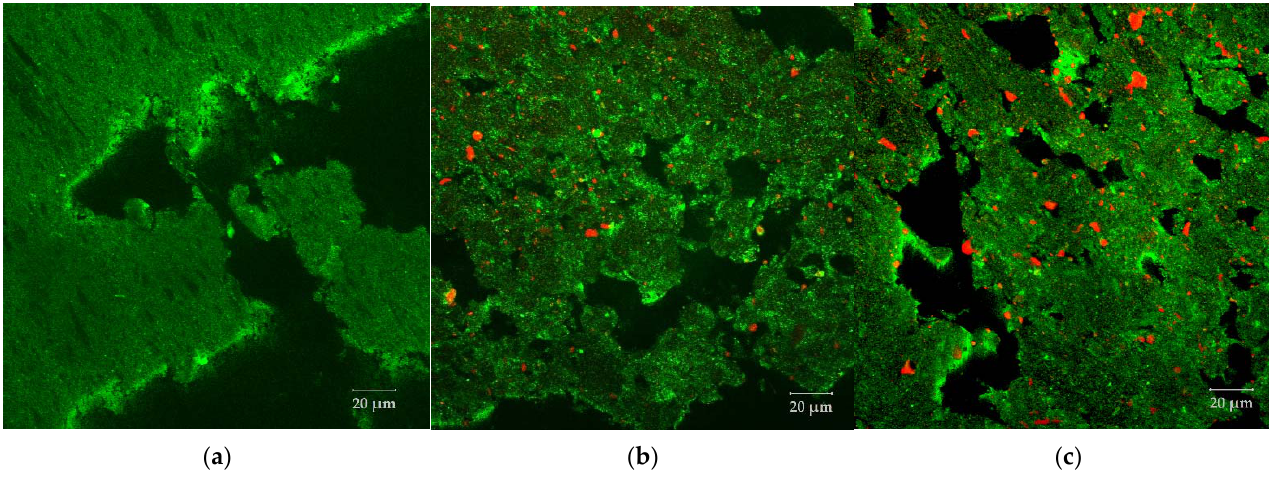
Figure 9. Morphology of the dispersed oil phase (red) in the protein matrix (green) for different oil contents. Confocal laser scanning microscopy (CLSM) images of samples with ( a ) 0%, ( b ) 2% and ( c ) 4% oil that was added at position 2. The barrel temperature was 120 °C and screw speed was 400 rpm.